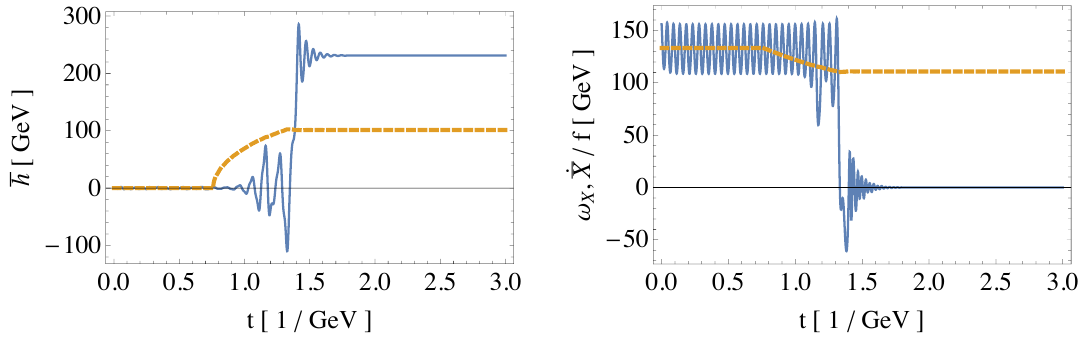
Figure 3 . The same (cid:12)gures as in (cid:12)gure 2 with the parameter set given in eq.